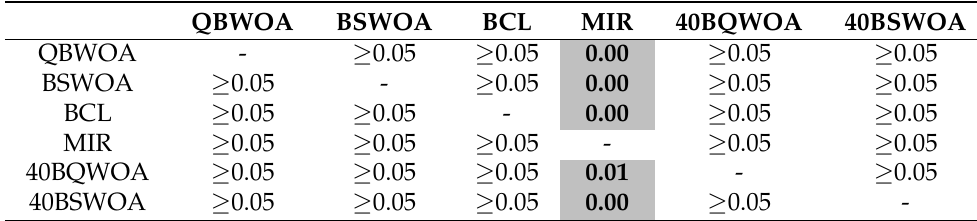
Table 5. Averages Statistical Test